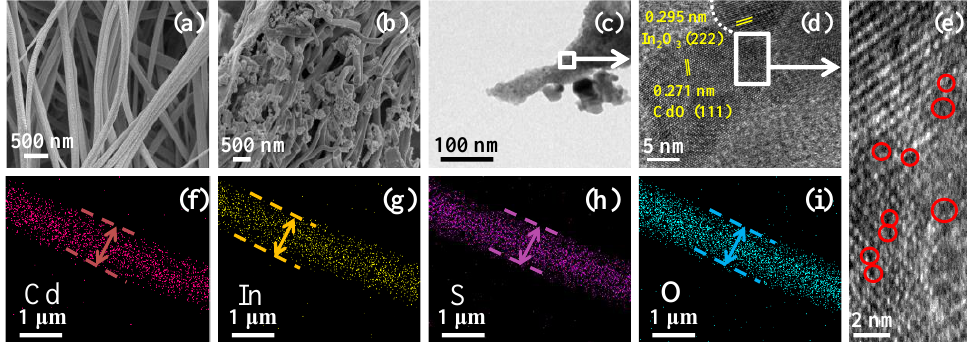
Figure 3. SEM images of S/CdO@In 2 O 3 -25 nanofibers ( a ) before calcination and ( b ) after calcination, ( c – e ) the corresponding TEM and HRTEM images and ( f – i ) EDS elemental mappings.